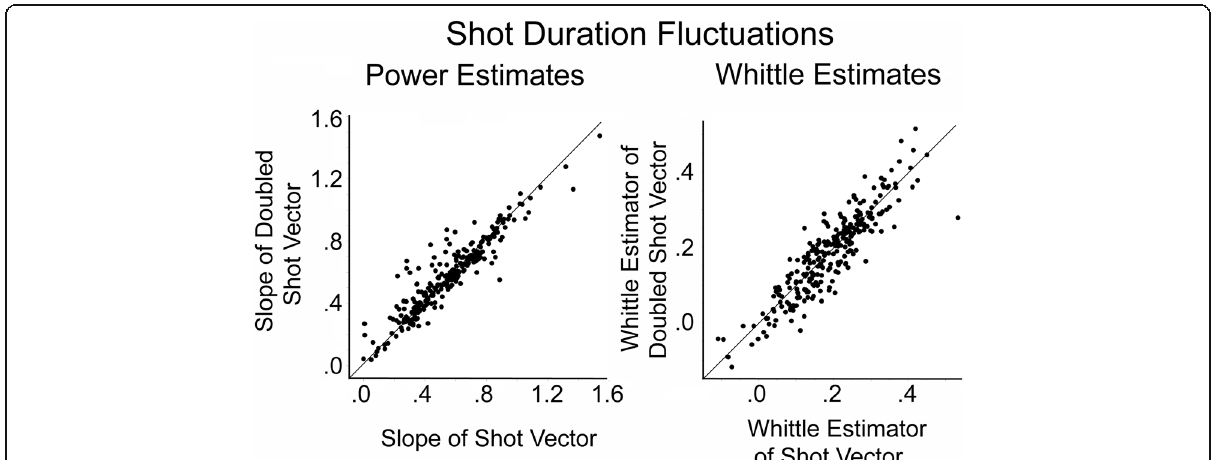
Fig. 6 Results of Study 4 where the shot vectors of movies were doubled, concatenated end to end. Slopes ( left ) and Whittle values ( right ) for the doubled shot vectors are plotted against the undoubled results of Studies 1 and 2. The diagonal lines represent equal values in both measures; they are not regression